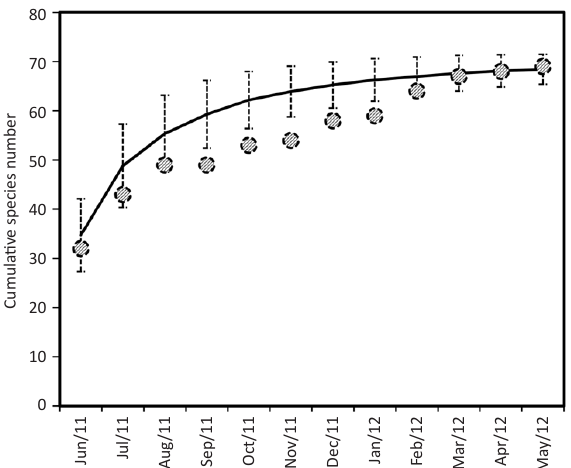
Figure 3. Accumulation curve of waterbird species recorded on the coastal area of the Quissamã Municipality, northern coast of Rio de Janeiro State, Brazil. Continuous line: Jackknife 1 estimator values, considering 1000 randomizations with